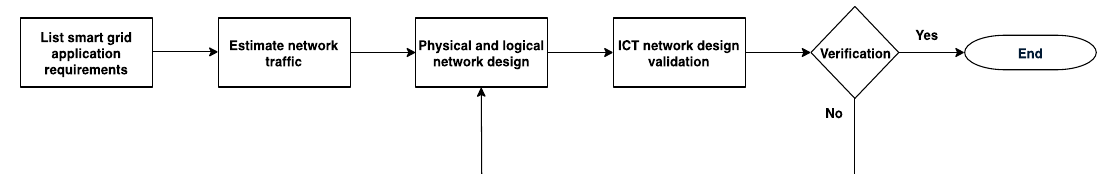
Figure 2. The design methodology flowchart.